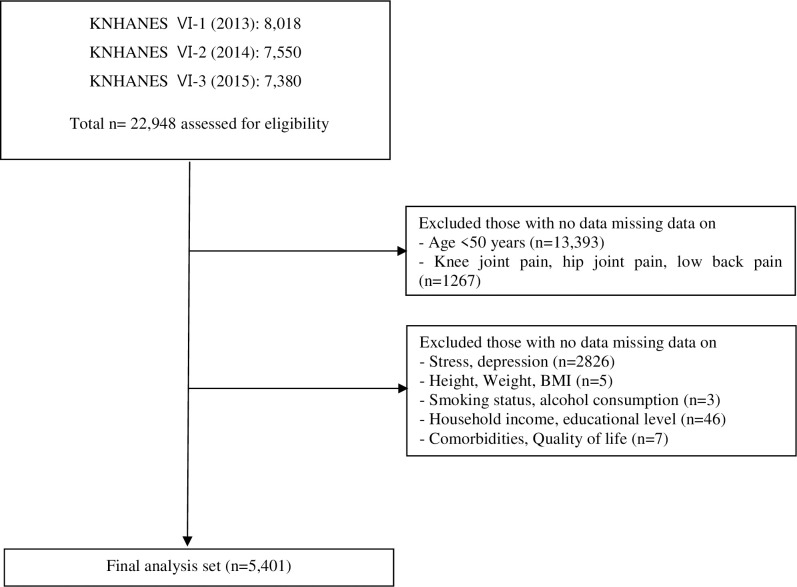
Subjects excluded from the analysis.KNHANES = Korean National Health and Nutrition Examination Survey; Comorbidities = angina, diabetes mellitus, hypertension, myocardial infarction, rheumatoid arthritis, and stroke.